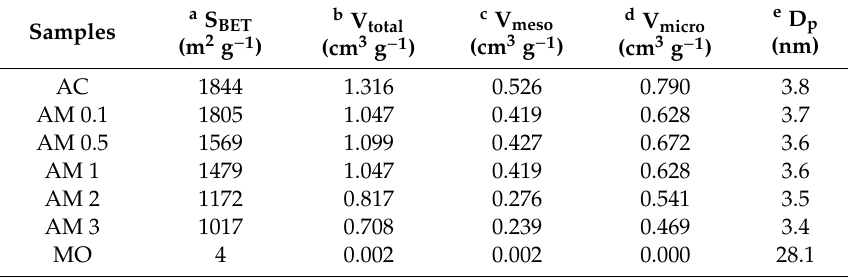
Figure 3. ( a ) N 2 adsorption/desorption isotherms (solid symbols represent desorption isotherms, and hollow symbols represent adsorption isotherms); and ( b ) pore size distributions of AC, MO and the AM composites. Table 2. The porous parameter of the as ‐ synthesized samples.